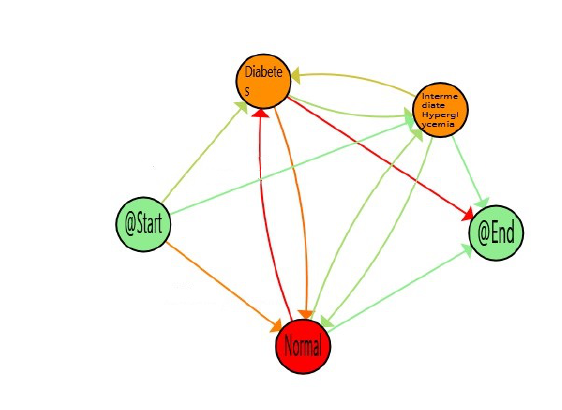
Figure 5. Dynamic fasting plasma glucose.